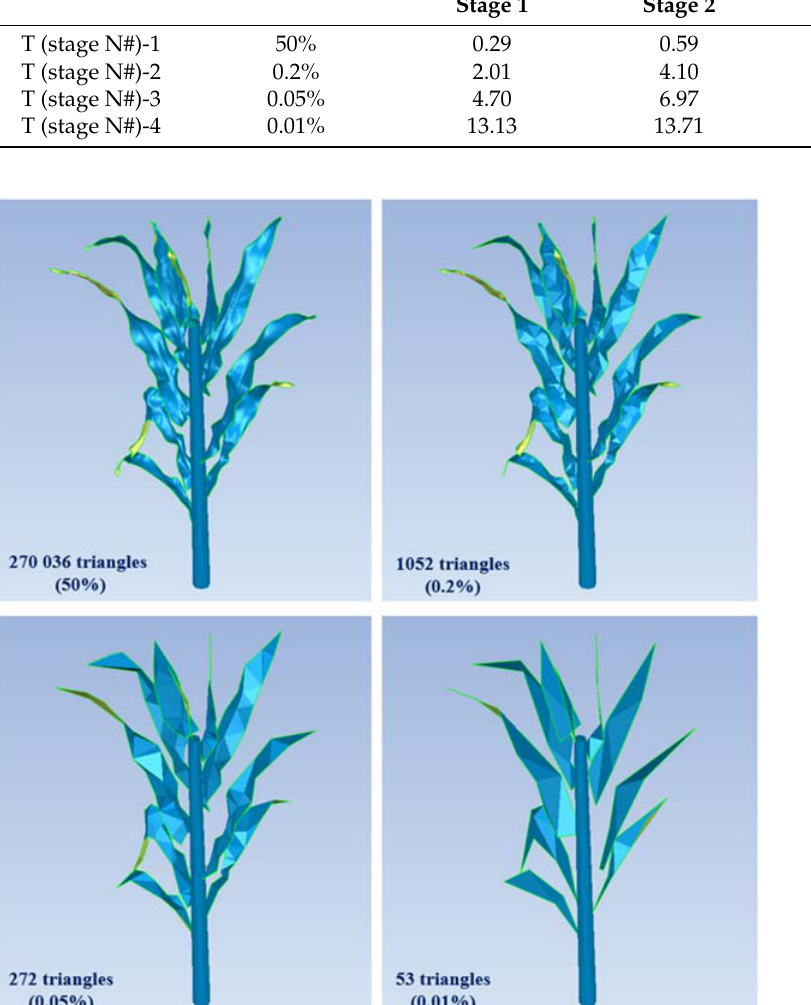
Figure 2. Representation of one plant in different decimation configurations (last stage of growth).